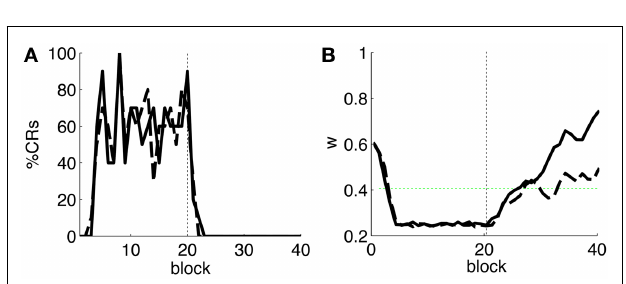
FIGURE 5 | Behavior of the model with simulated data. (A) Behavioral performance. Percentage of CRs per block of trials of the model fitted with stability constraint (solid line) and without (dashed line).The vertical dotted line separates acquisition and extinction training. (B) Trajectory of w in the model fitted with stability constraint (dashed line) and without (solid line). The horizontal green dotted line marks the level above which the model does not trigger any CRs. Blocks of 10